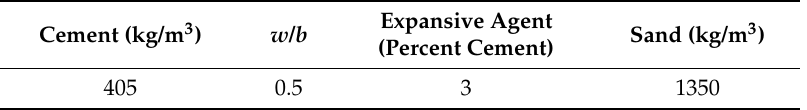
Table 5. The mix ratio of expansive cement mortar.